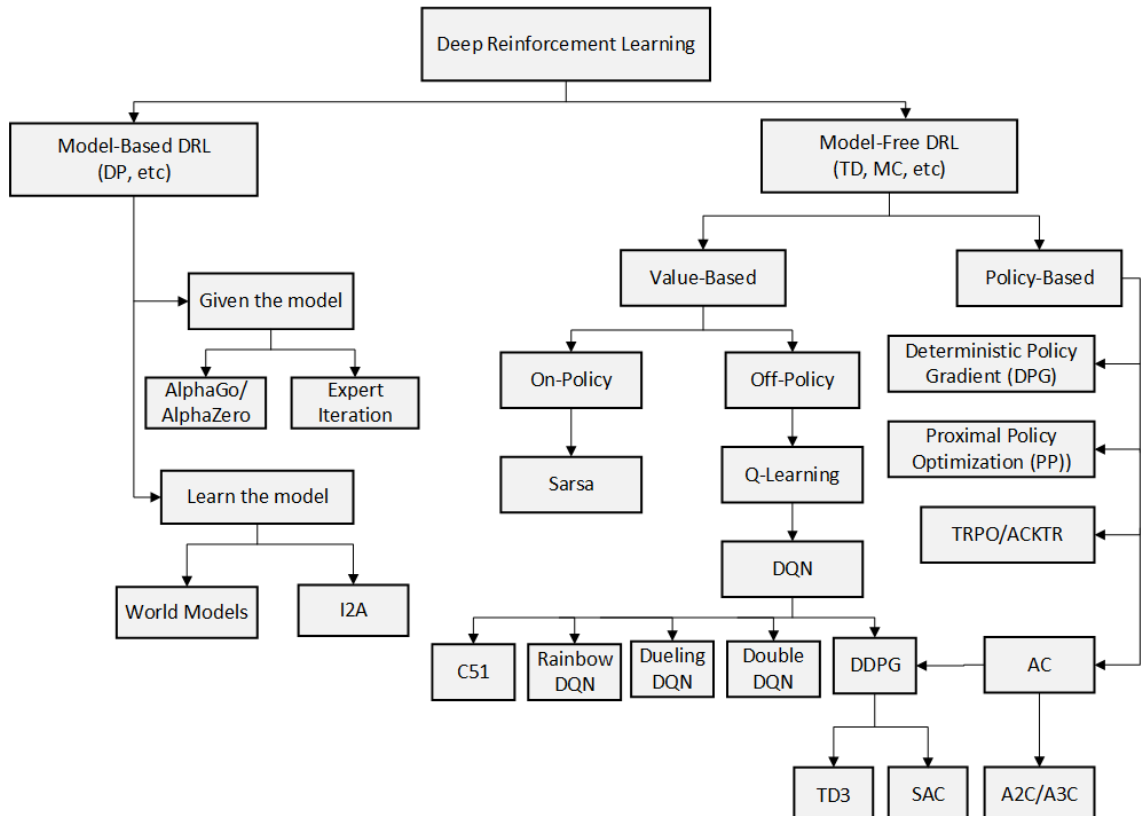
Figure 2. Taxonomy of Reinforcement Learning Algorithms. DP (Dynamic Programming), TD (Temporal Difference), MC (Monte Carlos), I2A (Imagination-Augmented Agent), DQN (Deep Q-Network), TRPO (Trust Region Policy Optimization), ACKTR (Actor Critic using Kronecker-Factored Trust Region), AC (Actor-Critic), A2C (Advantage Actor Critic), A3C (Asynchronous Advantage Actor Critic), DDPG (Deep Deterministic Policy Gradient), TD3 (Twin Delayed DDPG), SAC (Soft